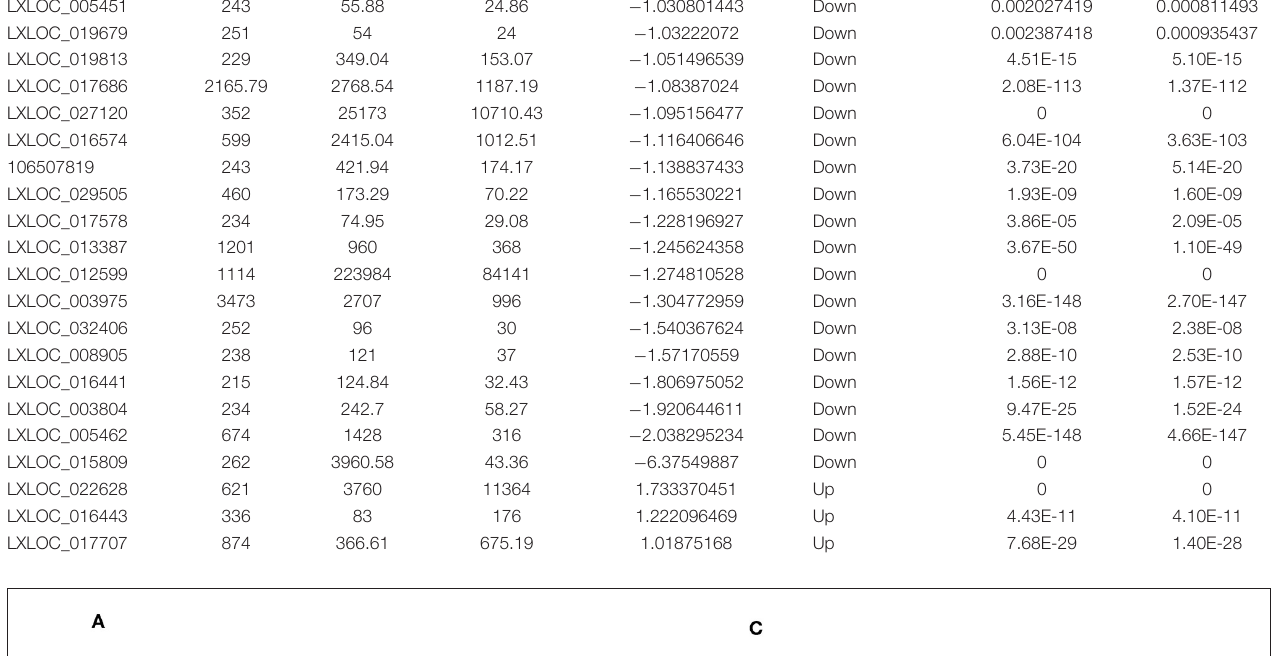
TABLE 4 | Differentially expressed lncRNAs.